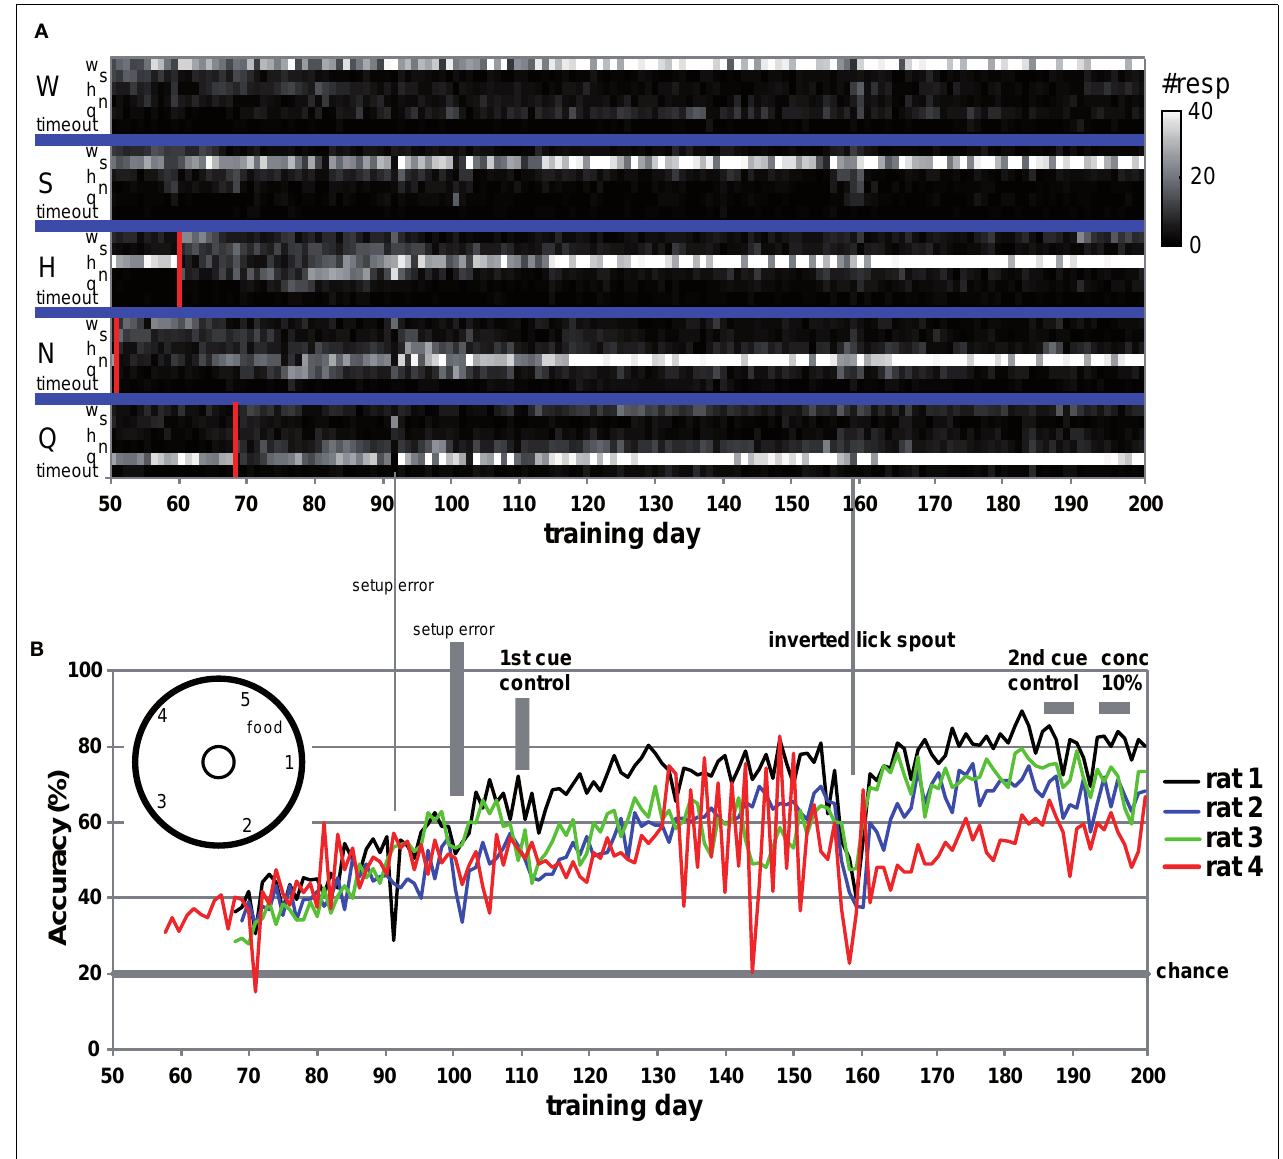
Cue-control generalization to training stimuli is indicated. Lick spout was mounted on bottom at indicated day for more natural lick behavior. Chance performance is 20%.Two setup errors are highlighted with a vertical bar, one affecting only rat